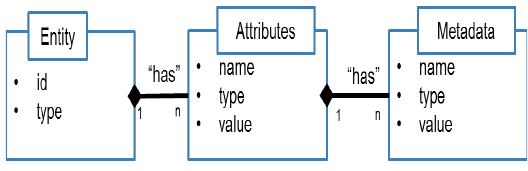
Figure 3. The difference among these elements is that attributes describe the entity and metadata describe attributes.